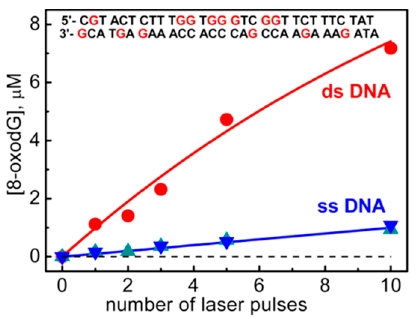
Figure 11. Dependence of the yields of 8-oxodGuo lesions in ds-ODN vs. ss-ODN on the number of successive 308 nm laser pulses. Taken from [58].